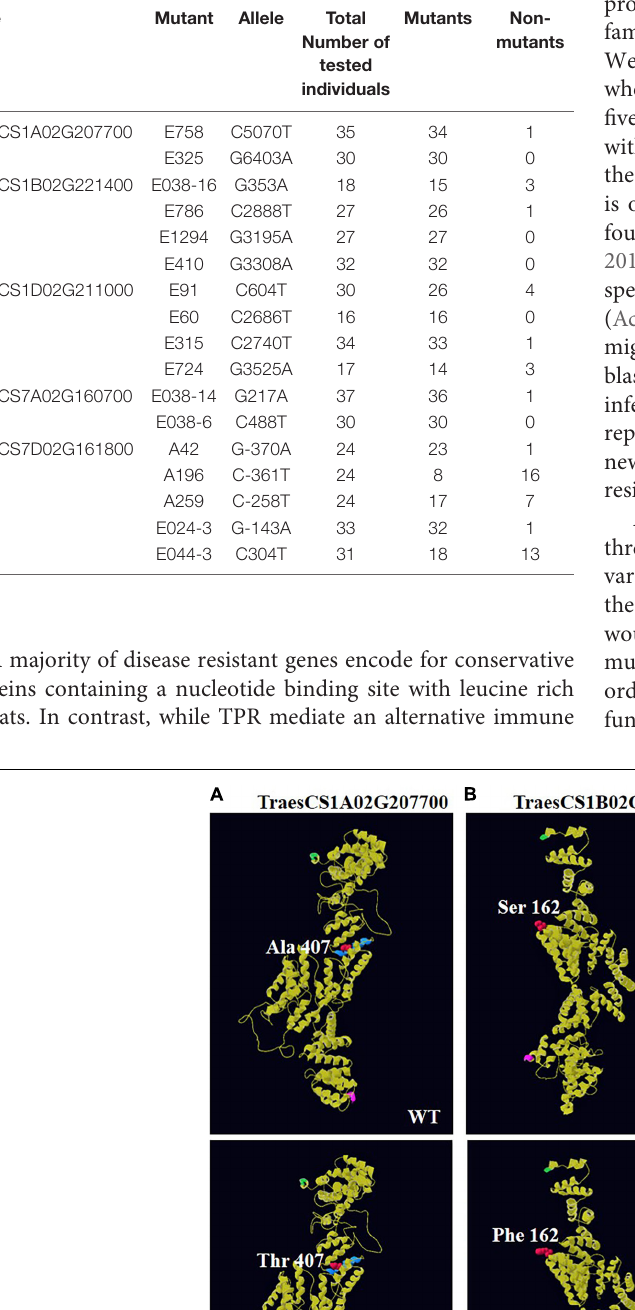
Frontiers in Genetics |